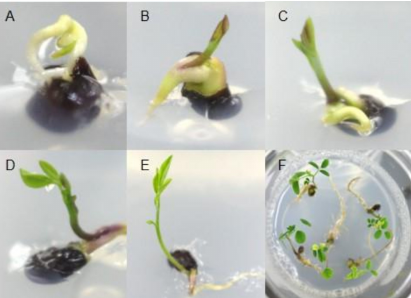
Figure 1. In vitro germination of Sophora flavescens Aiton. Three days ( A ), 5 days ( B ), 7 days ( C ), 10 days ( D ), and 14 days ( E ) after germination with root development. In vitro plant growth ( F ). Seeds were dipped in 2.0 mg / L GA 3 (Gibberellin A 3 ) for 24 h, and then the surface was sterilized. Then, they were placed on plant growth regulator-free MS (Murashige and Skoog)